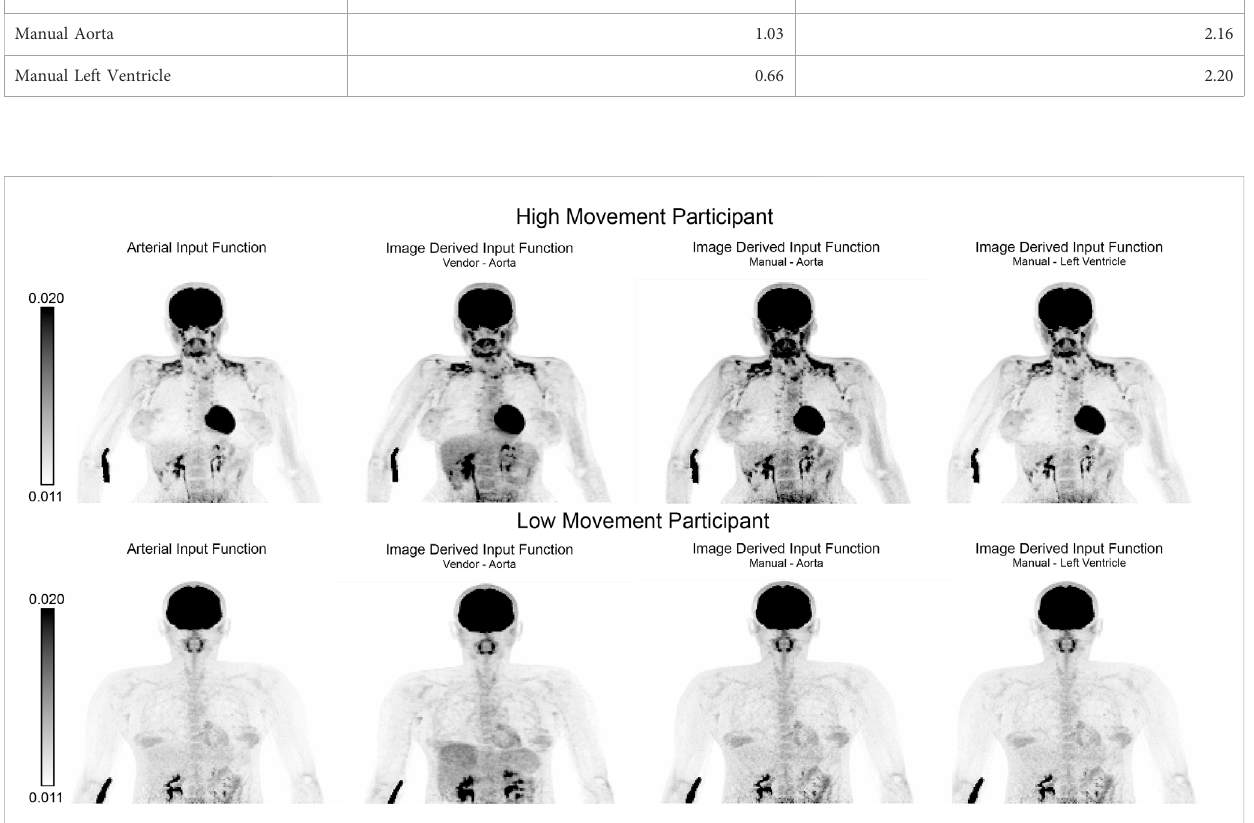
FIGURE 6 Qualitativecomparisonofwhole-bodyquantitativeoutputs.Maximumintensityprojectionsofwhole-bodyquanti fi ednetin fl uxconstant(Ki)images derived from different input functions for a representative high and low movement participant. Quanti fi ed images were derived using (from left to right): arterial input function (gold standard, P1), automatic vendor image derived input function (IDIF) extracted from the aorta (P2), manually extracted aorta IDIF and left ventricle